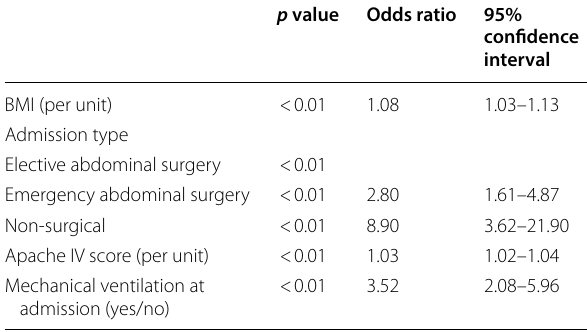
Table 5 Binary logistic regression of risk factors for IAH or ACS (n 489) =